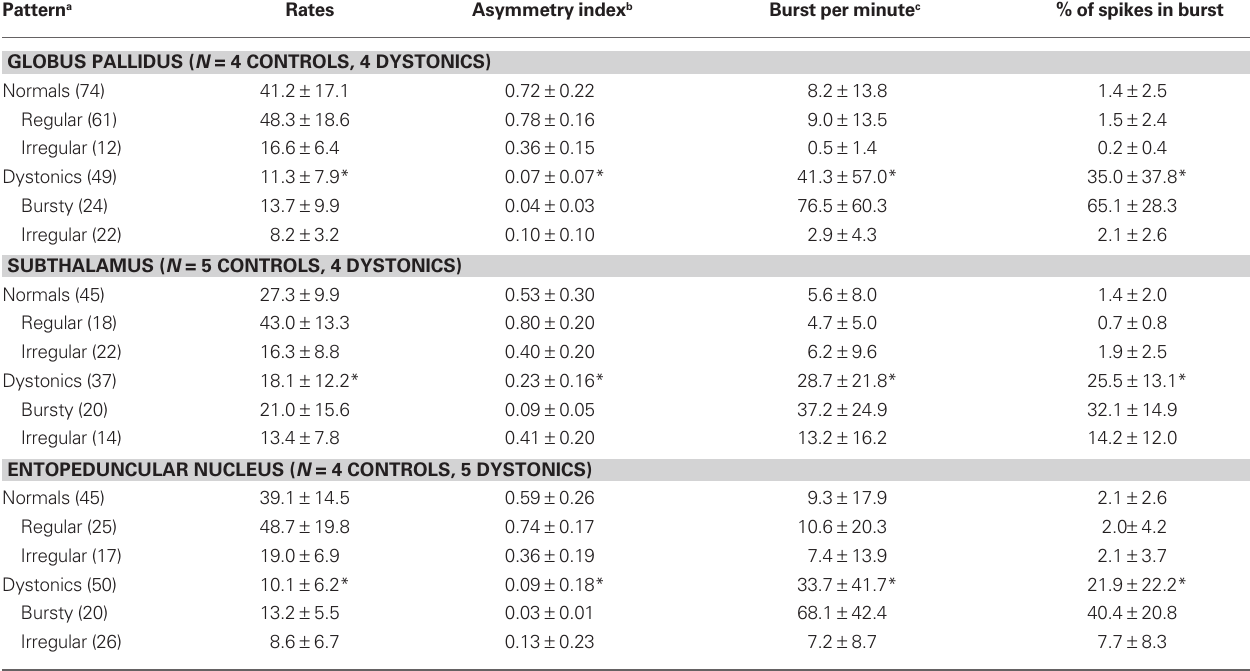
Table 1 | resting discharge rates and patterned activity in gP, STN, and eP ( n = 9 dystonic, 9 controls). Pattern a